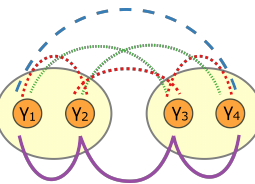
Figure 1: Two fermion sites (ovals) with four Majoranas γ bilinear terms are shown as lines above, and the single quartic term as the line below the